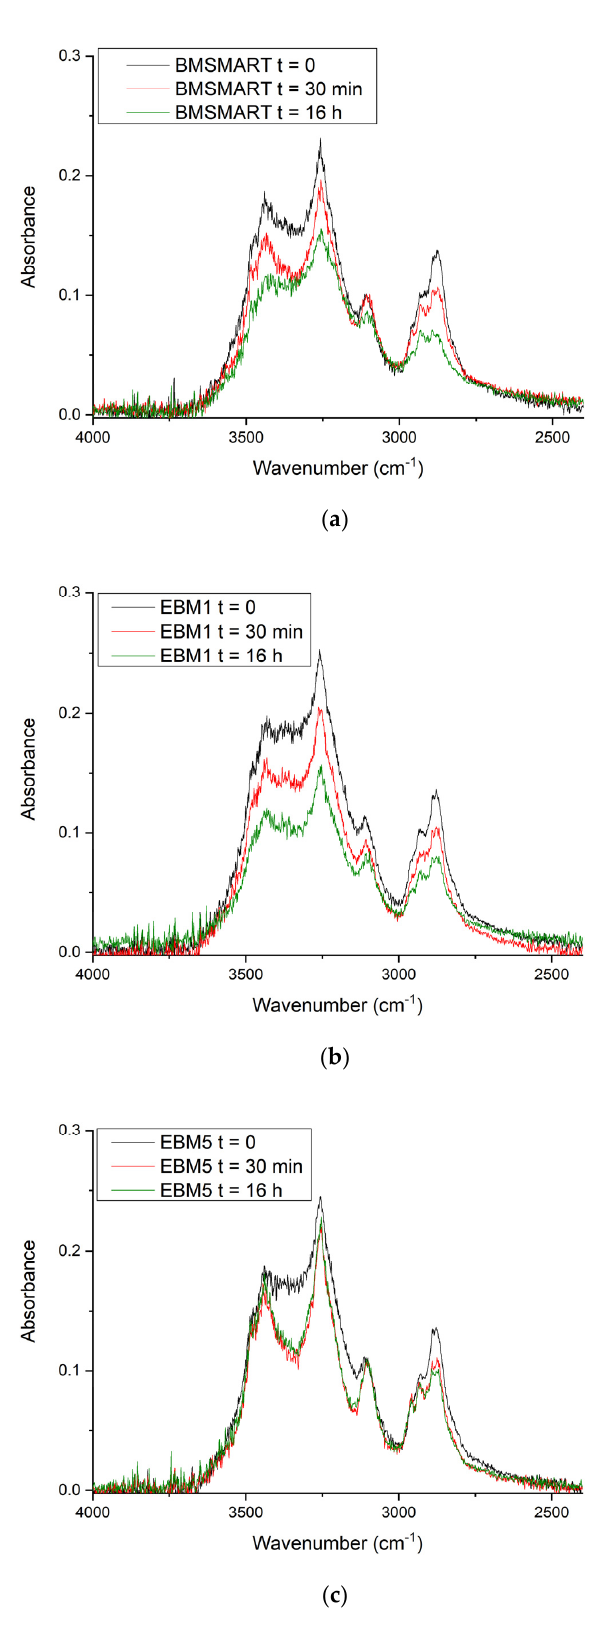
Figure 6. Infrared ATR spectrum related to the surface composition of: ( a ) coated BMSMART, ( b ) coated EBM1, ( c ) coated EBM5.